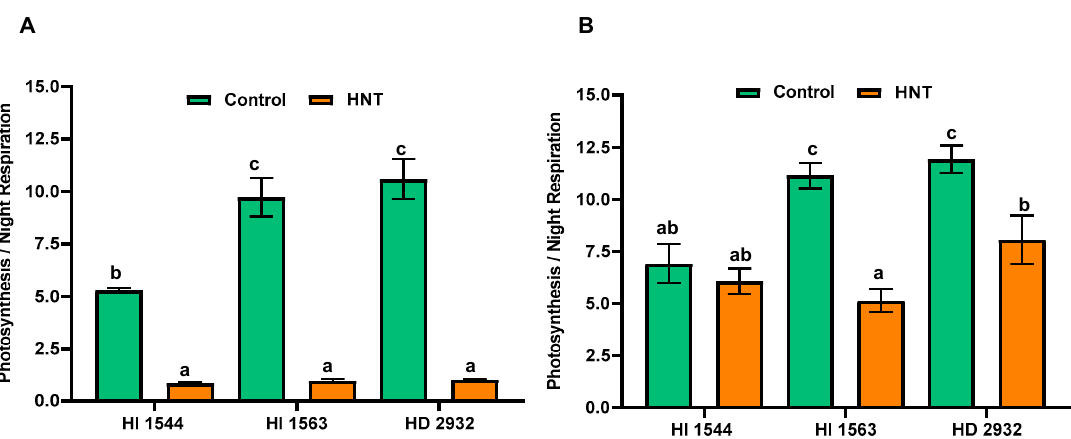
Figure 4. Ratio of photosynthesis to night respiration in the flag leaves of wheat genotypes grown under control and HNT conditions at ( A ) 10 and ( B ) 20 DAA. Values show mean ± SE. Data were obtained from three replications of each genotype. The separation of means was carried out using Duncan’s post hoc test ( p < 0.05). Means with different letters are significant.